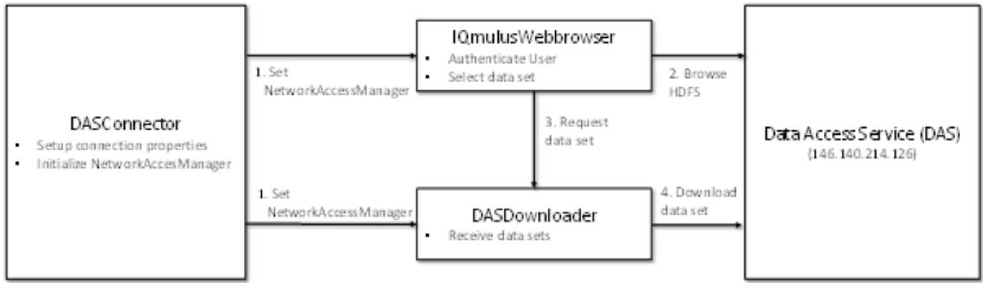
Figure 5. Components of the Fat Client involved in accessing data in the IQmulus infrastructure.